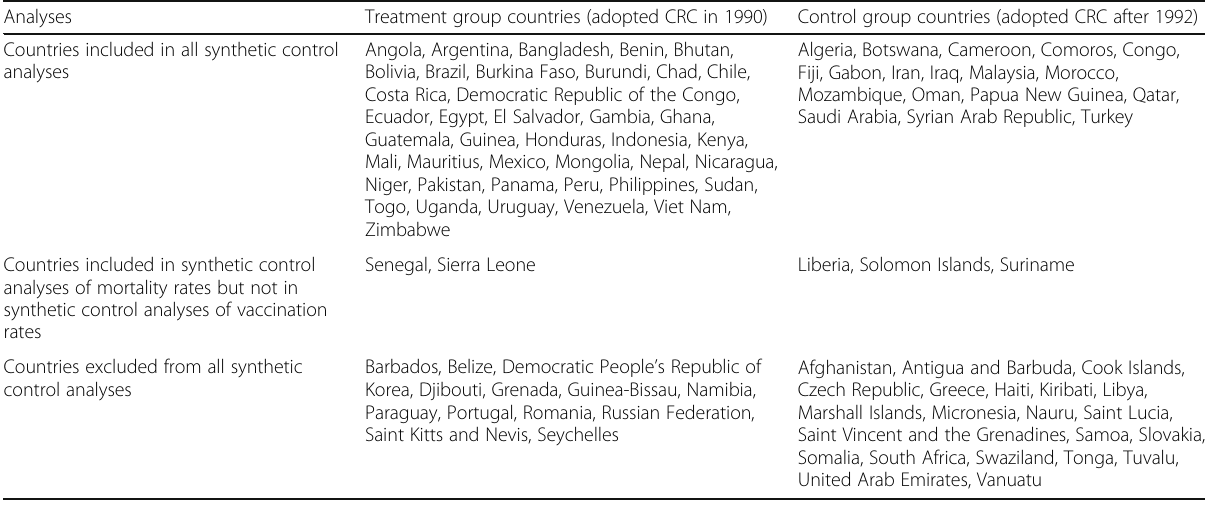
Table 6 Countries included in and excluded from groups in synthetic control analyses